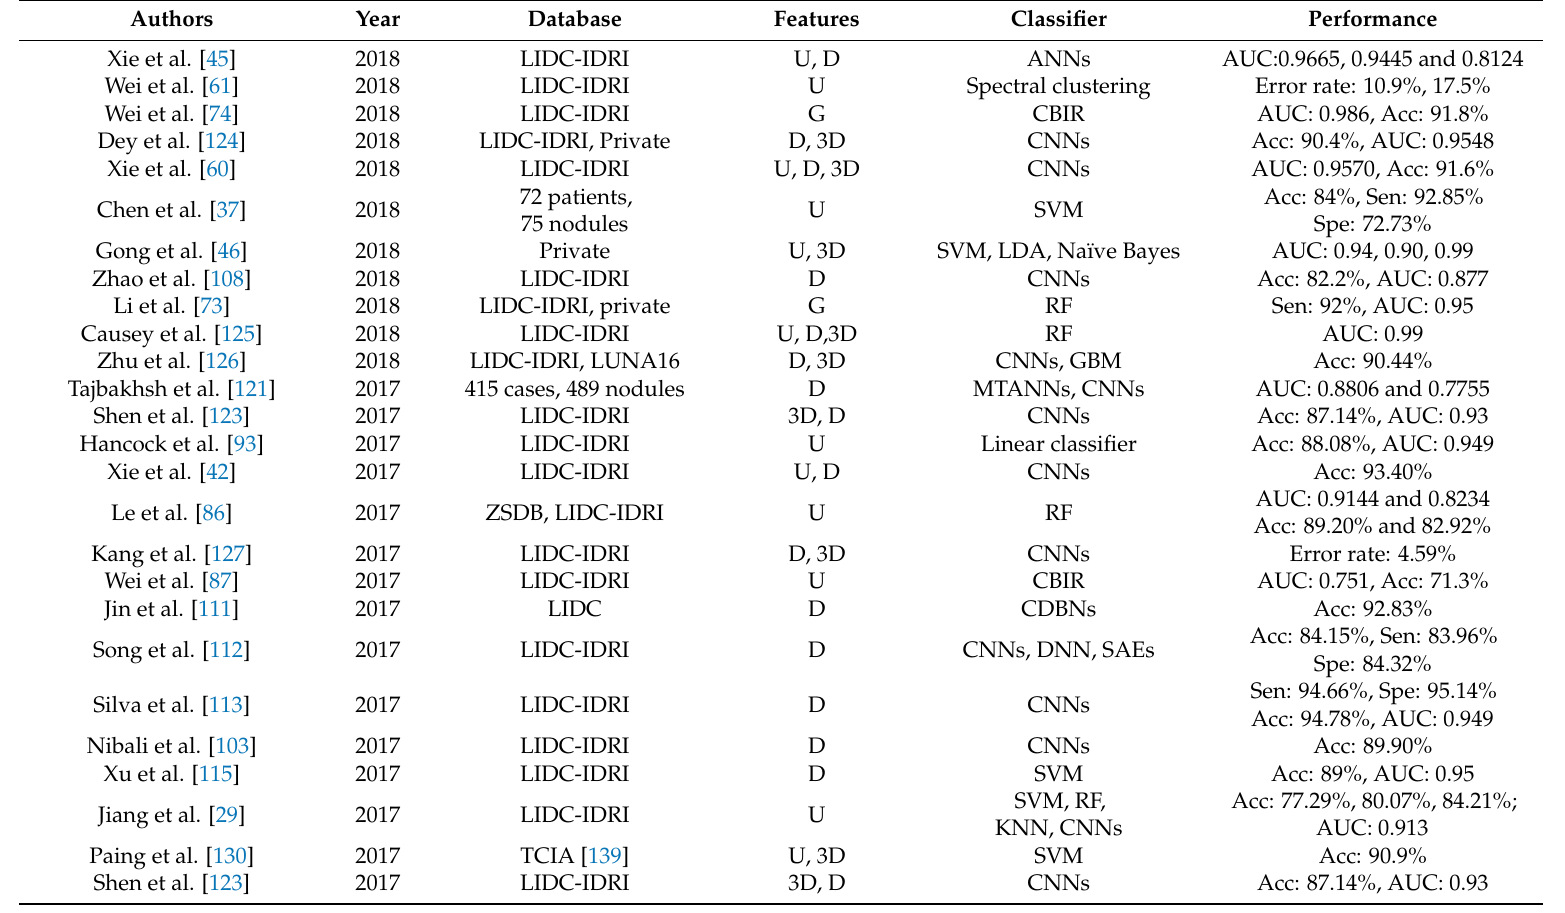
Table 4. Main techniques and comparative analysis of the two-type classification. U: user-defined features, G: Generic features, D: deep features, 3D: 3D features, O: other methods. Acc: accuracy, Sen: sensitivity, Spe: